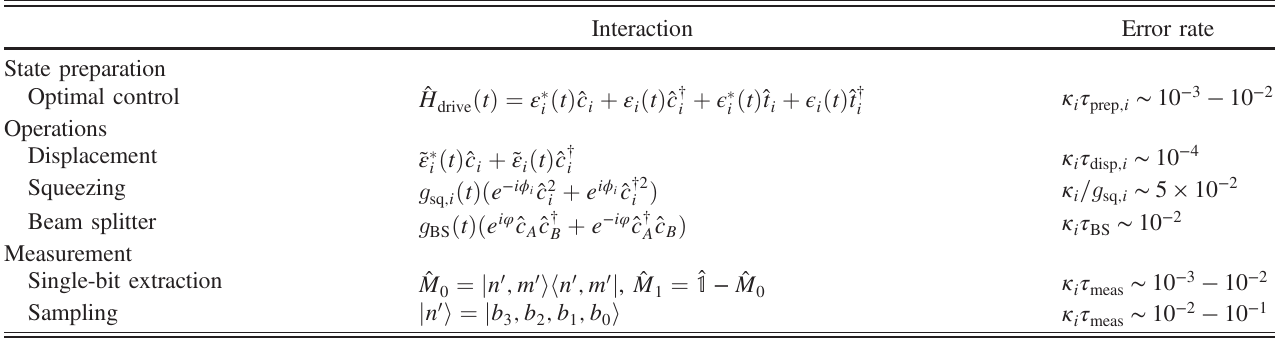
TABLE I. Full set of controls of the bosonic processor. The subscripts i ∈ f A; B g correspond to operations on each cavity and their and κ are the intrinsic linewidths of the cavity modes. Optimal control pulses that utilize both resonant respective ancillary modules. κ A B t Þ and ϵ t Þ , respectively, generate a desired initial Fock state (see Appendix D). cavity and ancilla drives with complex envelopes, ε i ð i ð j n 0 ; m 0 i denotes a particular joint photon number to be measured in the cavities, and f b i g represent the bits associated with the binary decomposition of the photon number. For example, j 5 i ¼ j 0101 i . The third column presents an estimate of the expected limits on fidelity due to photon loss for the hardware in this current implementation of the